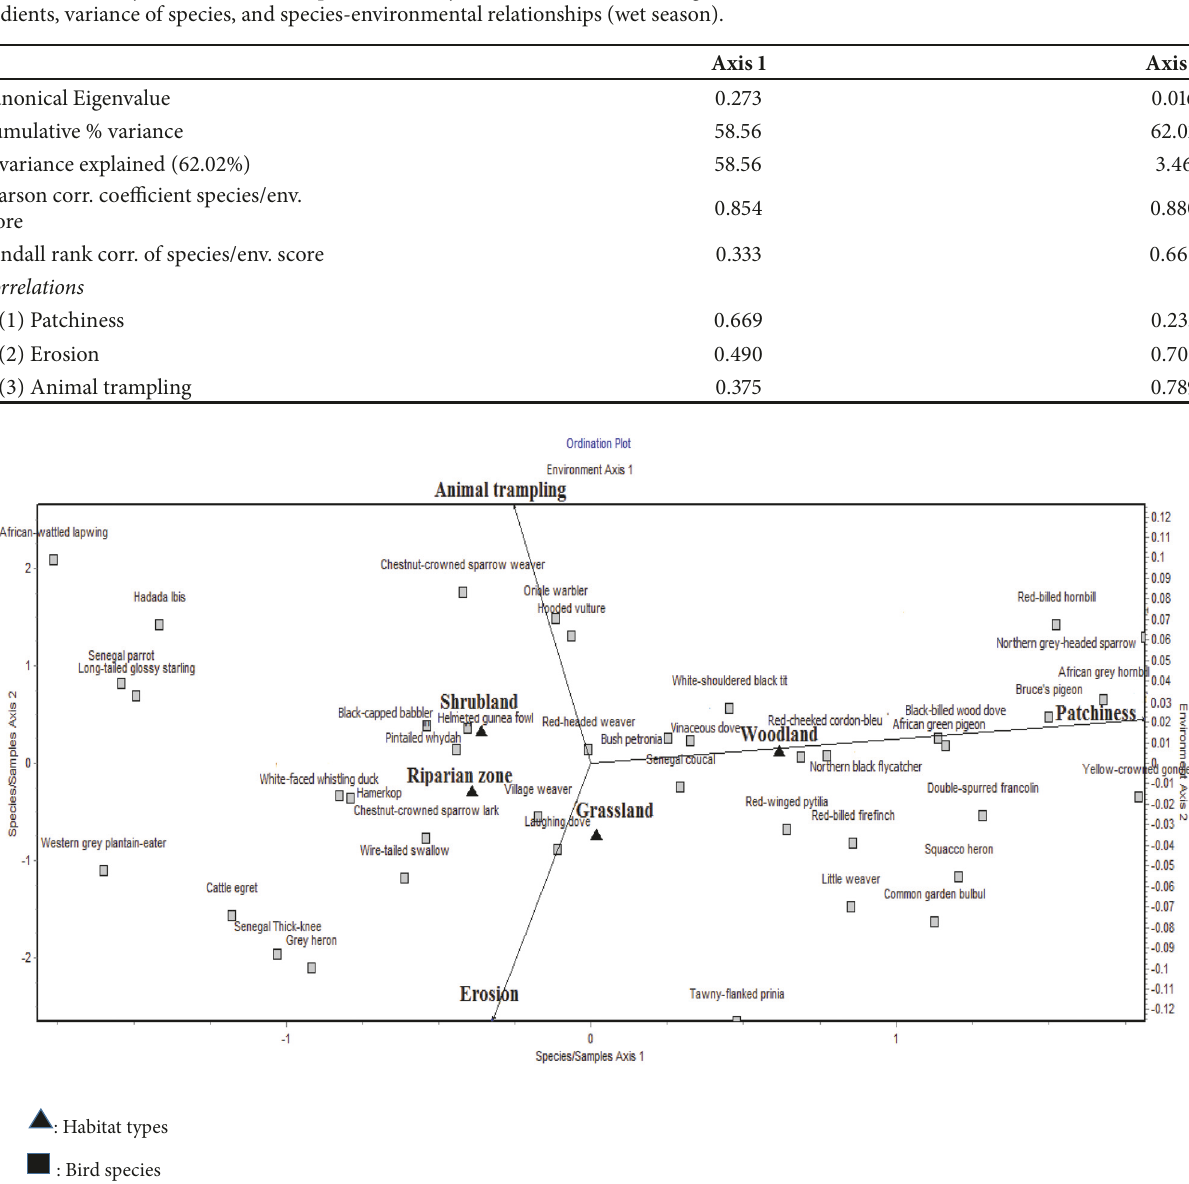
Figure 7: Canonical correspondence 773 (CCA) ordination diagram, showing the relationship between environmental disturbances and bird species across the four habitat types in the wet season. The arrows represent each of the environmental variables plotted pointing in the direction of maximum change of explanatory variables across the four